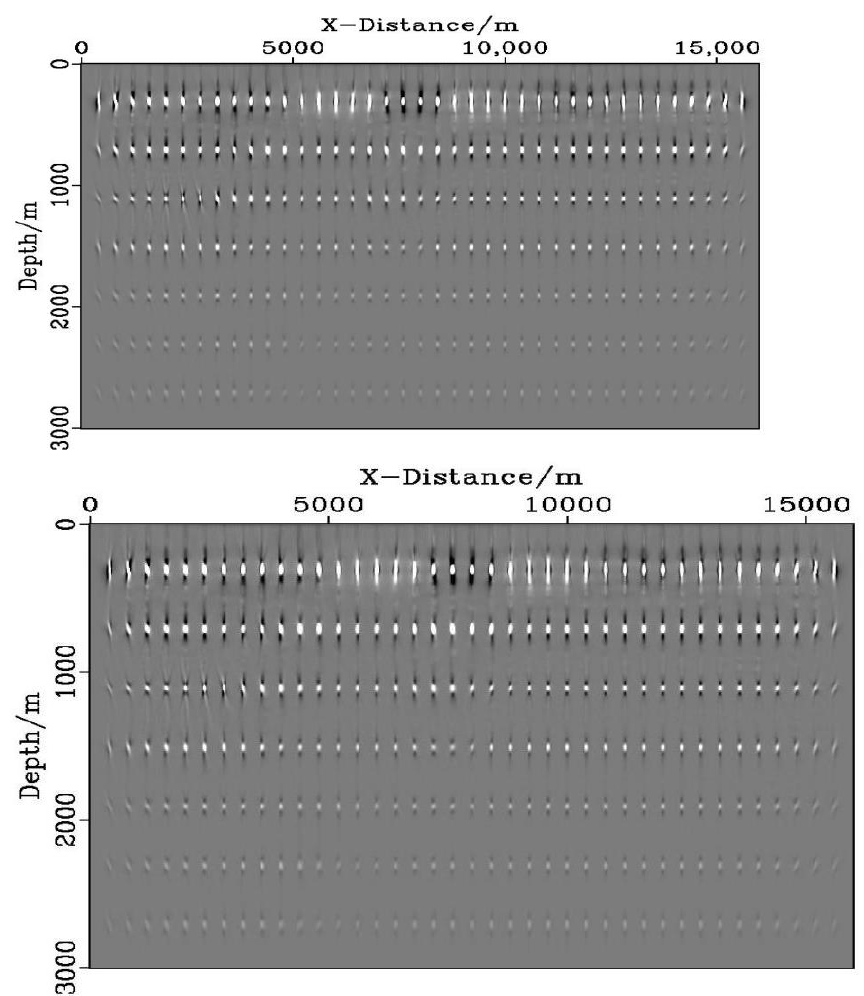
Figure 4. The 2D Display of the X-Z tangent plane of the point spread function.